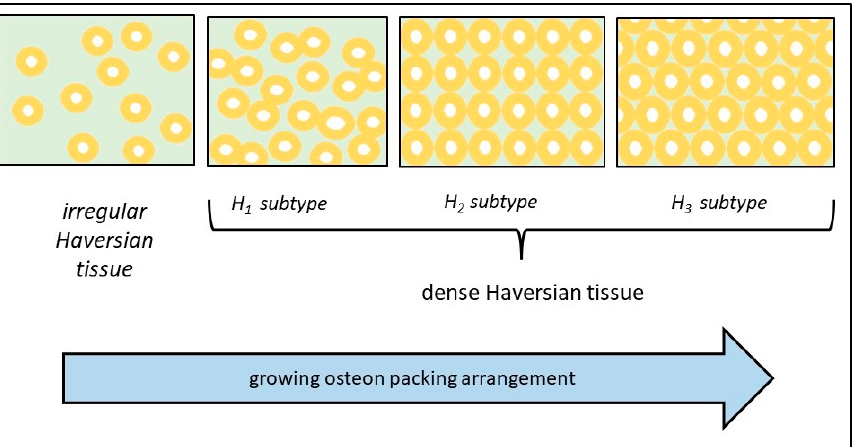
Figure 5. Schematic representation of the di ff erent osteon arrangements in Haversian bone tissue.